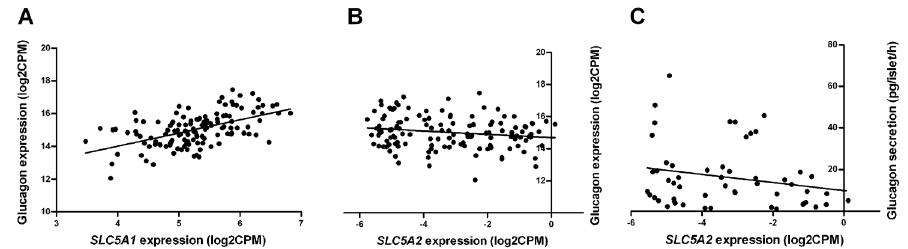
Fig 4. The gene expression of SLC5A2 and SLC5A1 in human pancreatic islets correlated with glucagon gene expression. The mRNA expression of SLC5A1 (panel A, n = 131, r = 0.53, q-value < 0.0001), but not SLC5A2 (panel B, n = 131, r = -0.15, q-value = 0.19), correlates with the expression of the glucagon gene or secretion of glucagon at 1 mM glucose (panel C, n = 54, r = -0.27, p = 0.11) in human